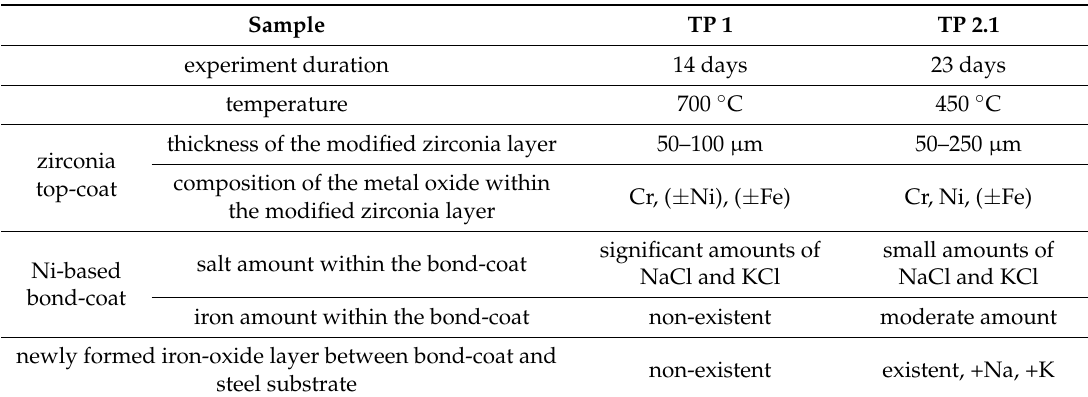
Table 4. Summarized observations for the in situ test